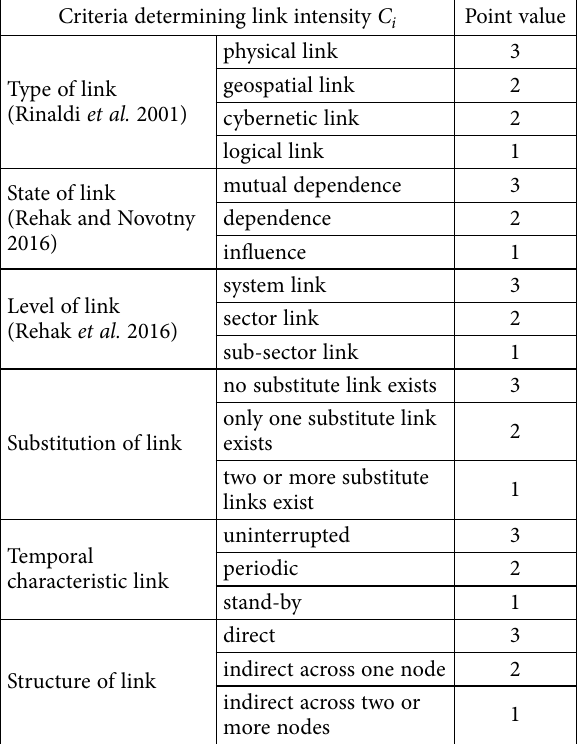
Table 2. Point values of the criteria determining link intensity Criteria determining link intensity C i Point value Type of link (Rinaldi et al.